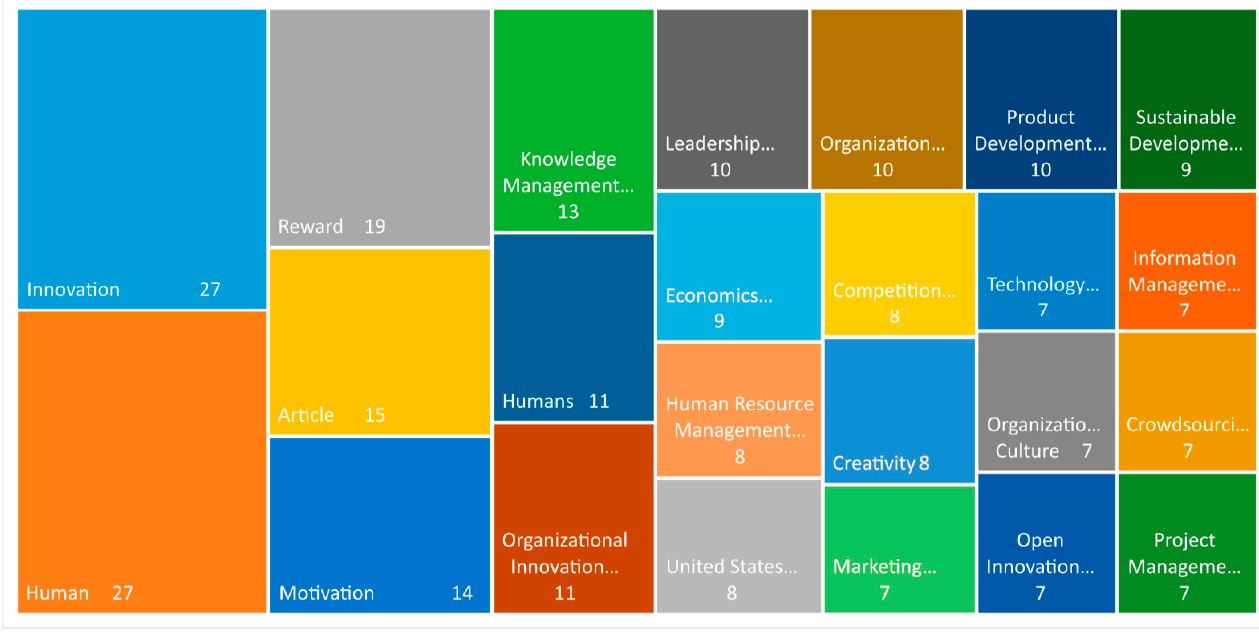
Figure 9. Scopus keyword analysis. Source: created by the